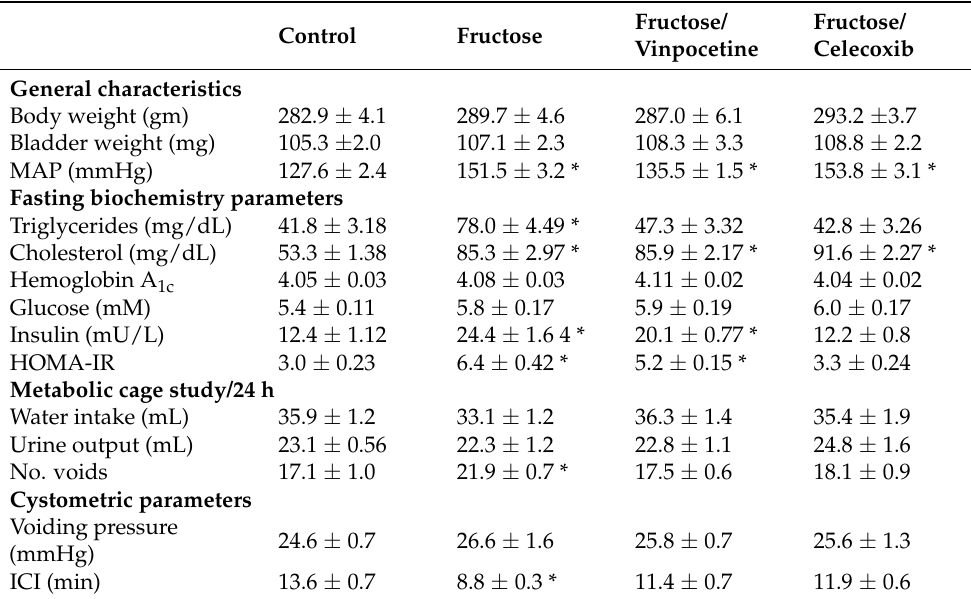
Table 1. General characteristics and micturition behaviour of experimental animals.